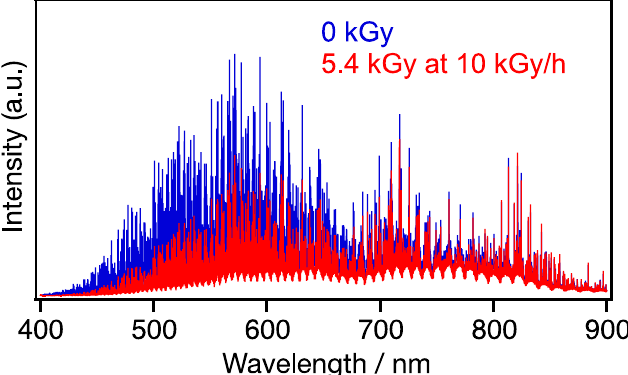
Figure 2. Emission spectra of the surrogate nuclear fuel debris with and without gamma irradiation at a dose rate of 10 kGy/h.